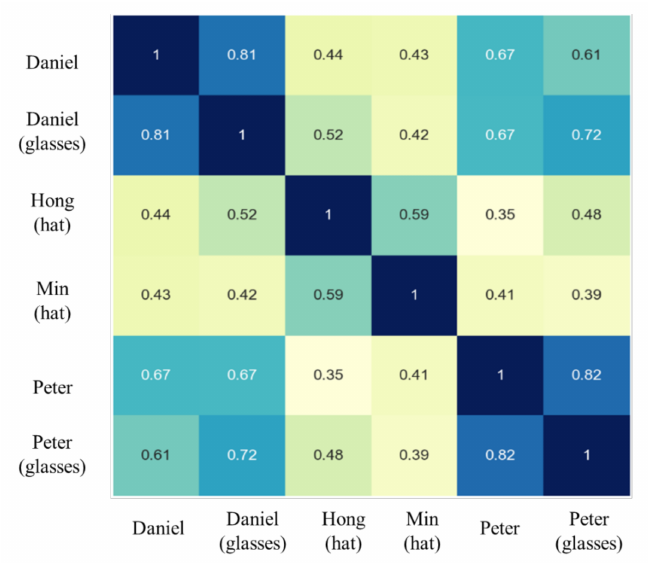
Figure 16. Example of falsely rejected face images.